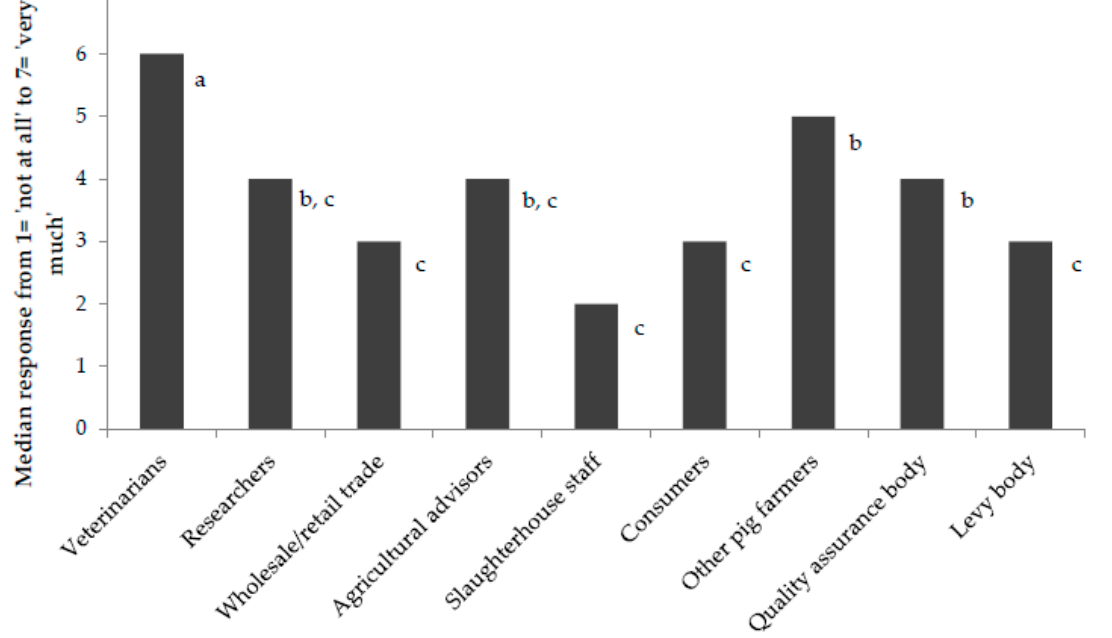
Figure 2. Farmers’ median response to the question: ‘How much does the opinion of this person/group affect your decisions with regard to mixing aggression?’ (from 1 = ‘not at all’, to 7 = ‘very much’). Letters indicate results of post-hoc pairwise comparisons whereby different letters indicate a significant difference between groups at p < 0.05. Table 3. Percentage of respondents who had tried each aggression mitigation strategy and the median usefulness score for each strategy (from 1 = not useful at all to 7 = very useful). Different letters indicate significantly different usefulness scores at p < 0.05.